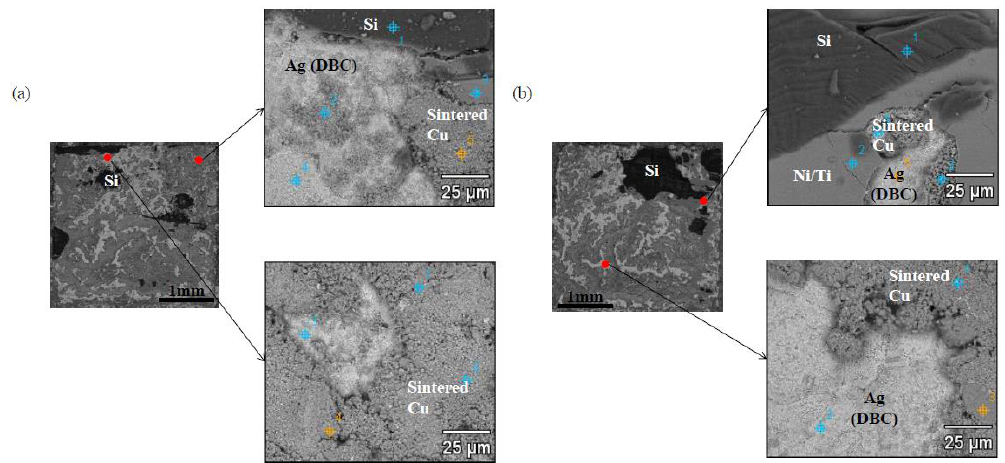
Figure 10. Fracture surfaces of the Cu-sintered joints after die shear testing at: ( a ) 10 MPa, 30 min and ( b ) 10 MPa, 60 min.